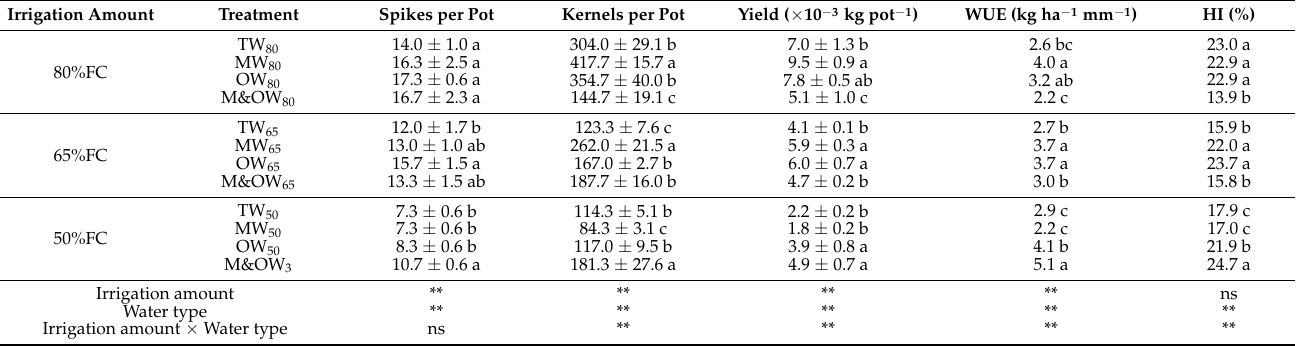
Table 2. The yield, yield components, water use efficiency (WUE), and harvest index (HI) of winter wheat with different water irrigation.